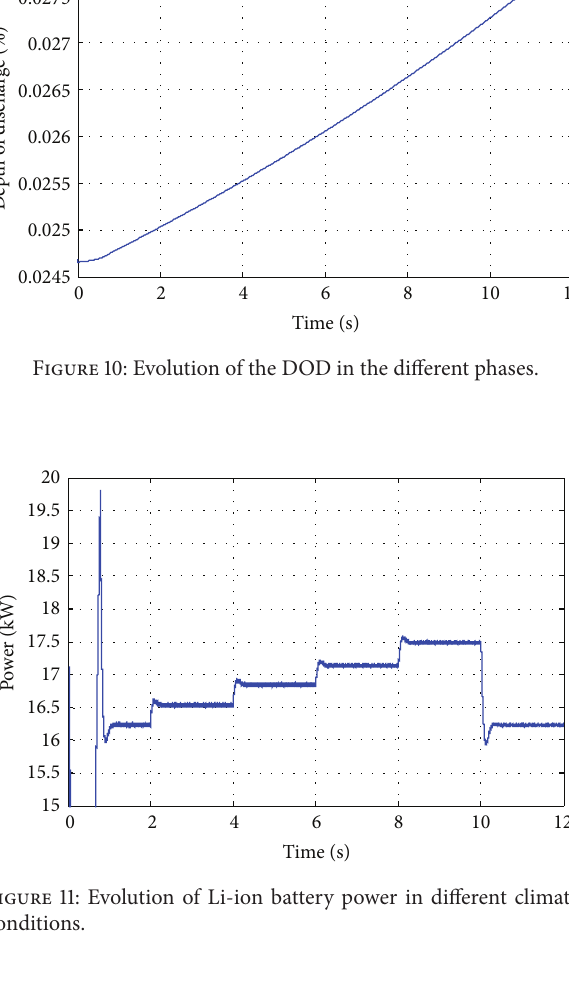
Table 2: Power consumption